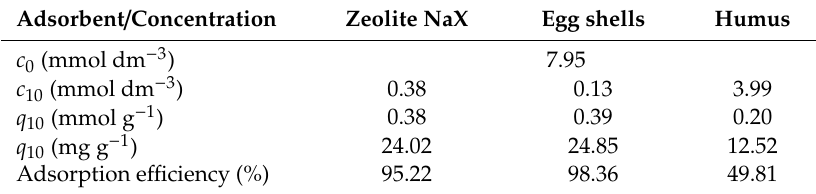
Table 1. Experimental data obtained after 10 days of adsorption process. Adsorbent / Concentration Zeolite